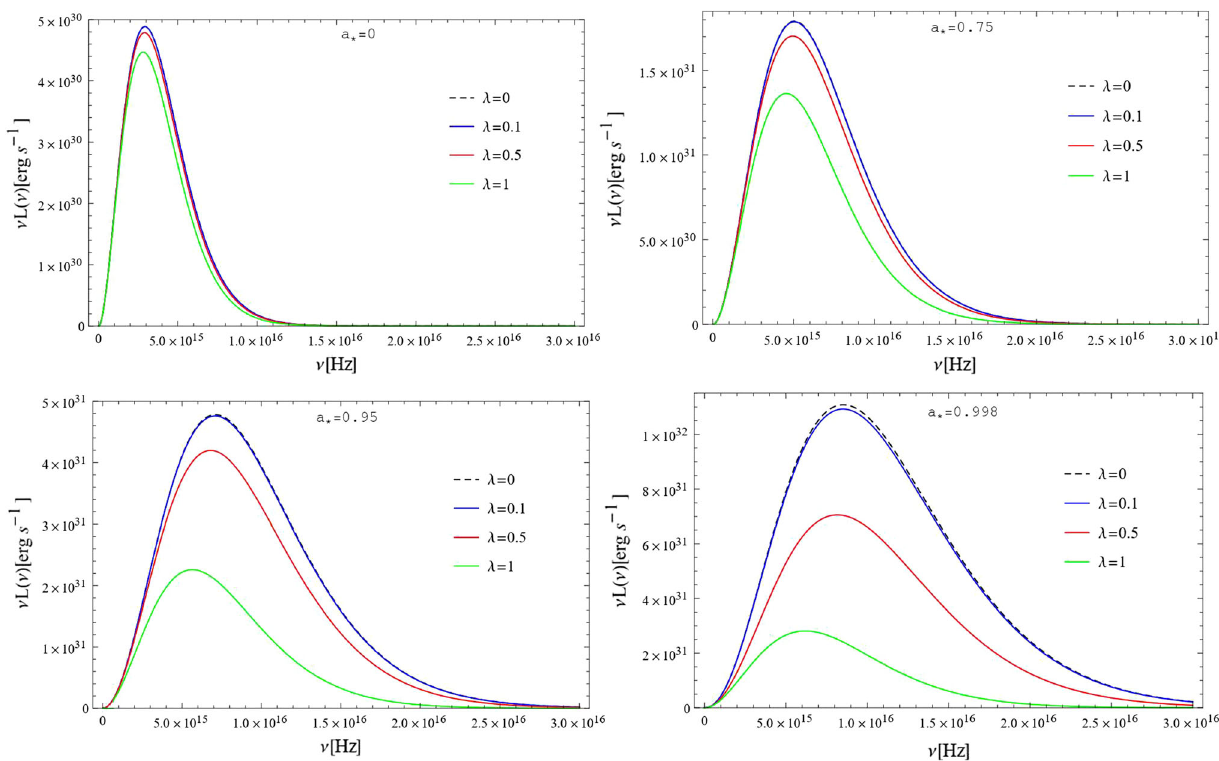
Fig. 4 The emission spectra ν L (ν) of the accretion disk for a RDSWH plotted for different values of λ and compared with the Kerr BH